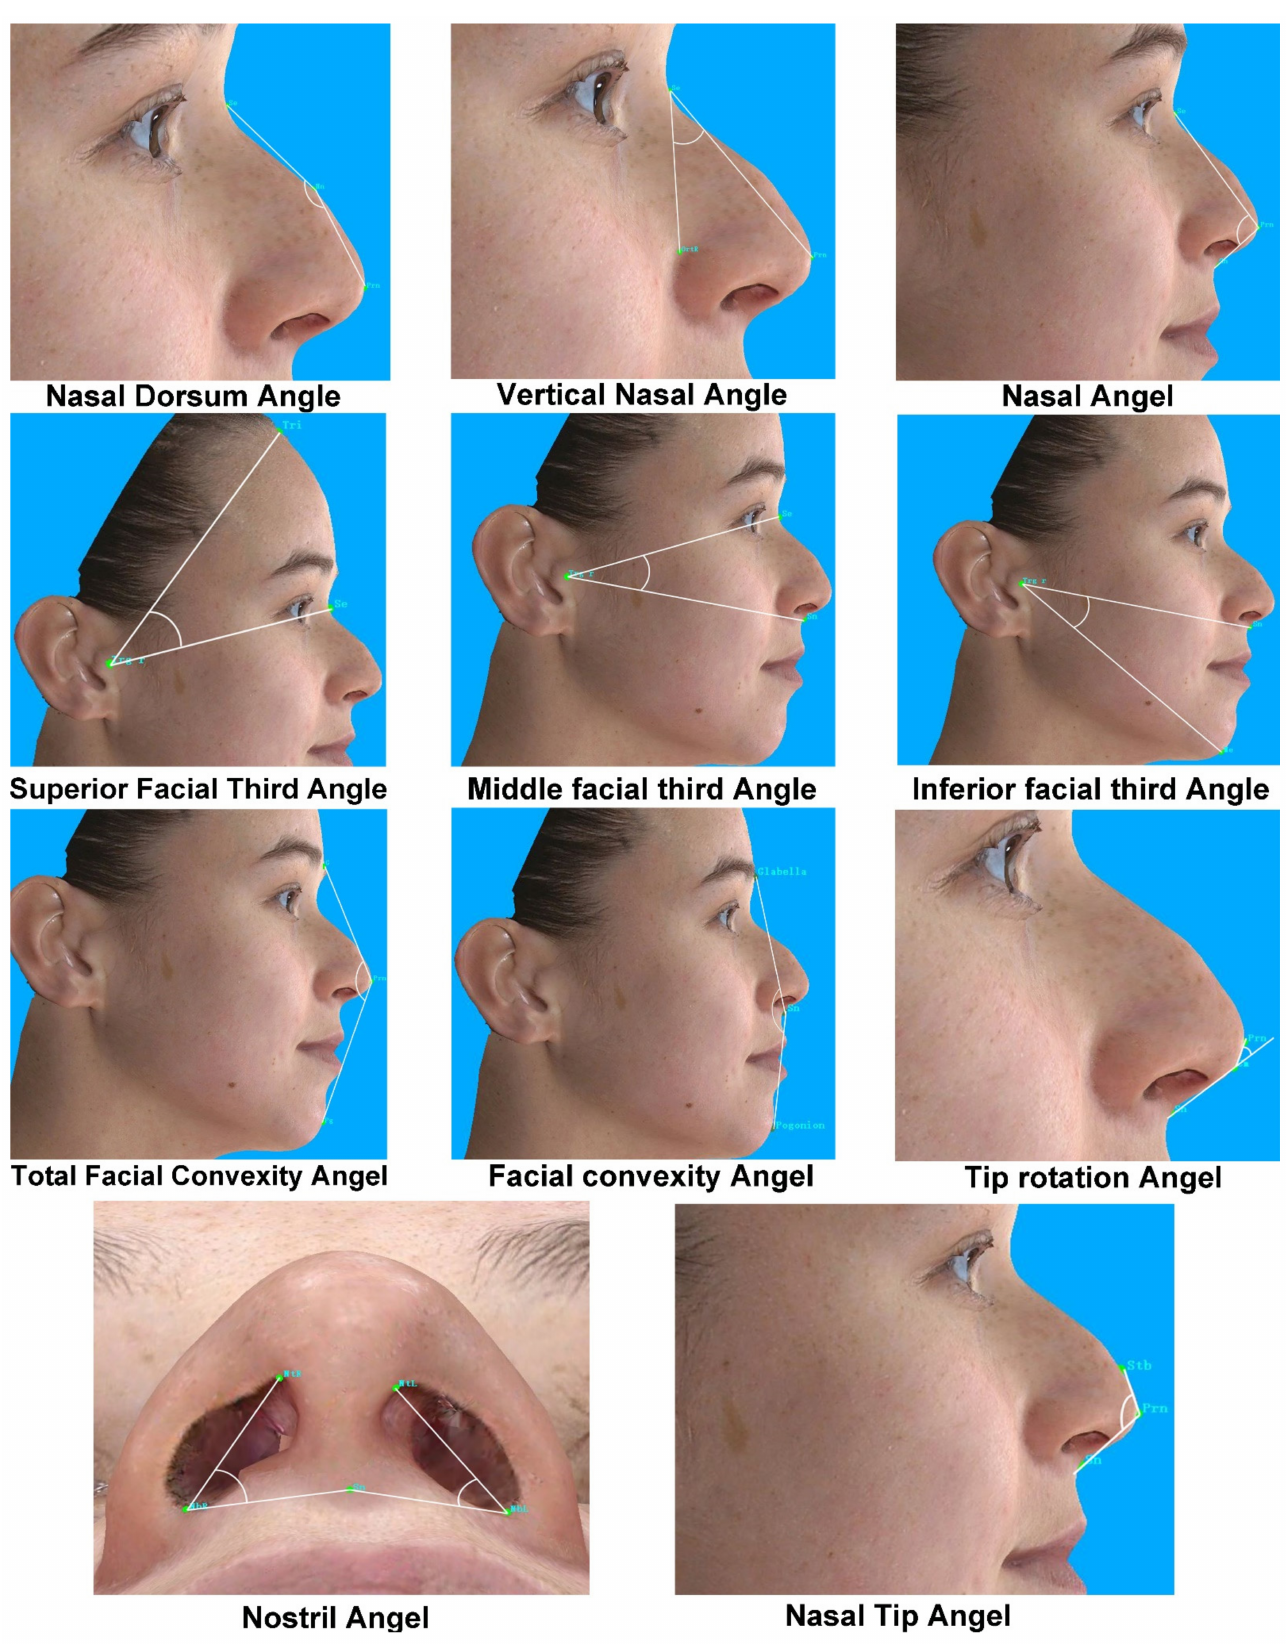
Figure 4. The angular measurements of novel